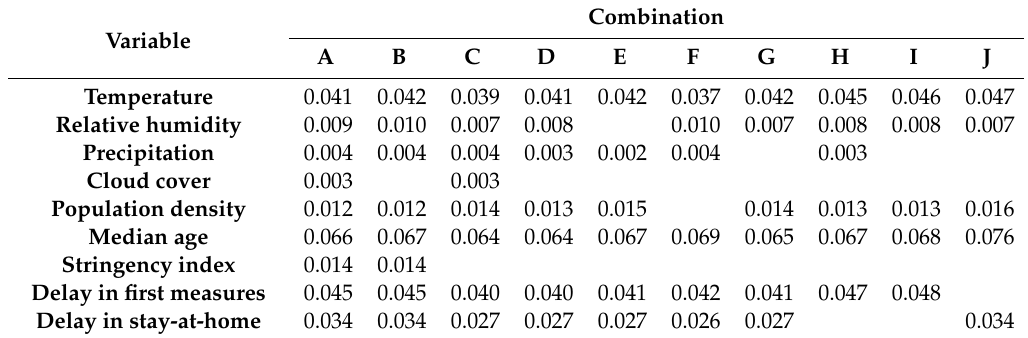
Table 2. Increase in coe ffi cient of determination ( ∆ R 2 ) due to inclusion of variables in Equation (3). Variable